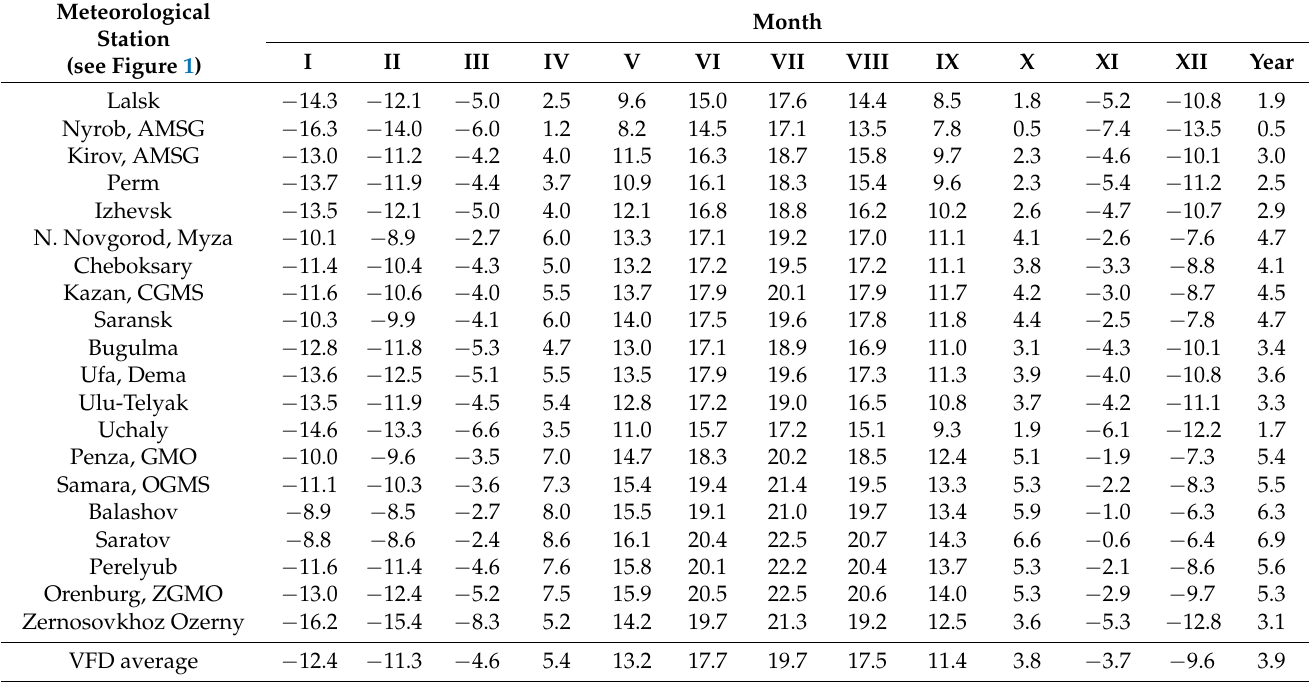
Table 1. Monthly and annual average air temperatures ( ◦ C) in the Volga Federal District (VFD) during 1966–2021.